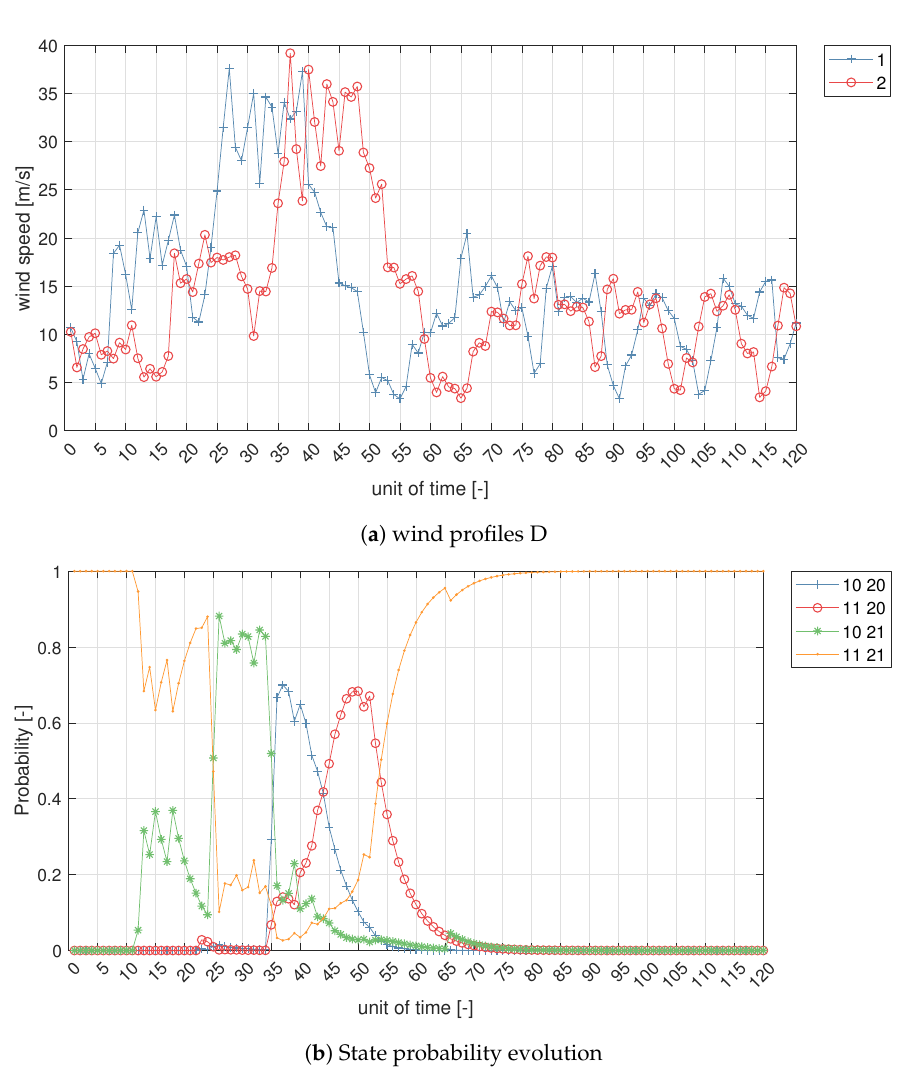
Figure 9. Long Run Simulation